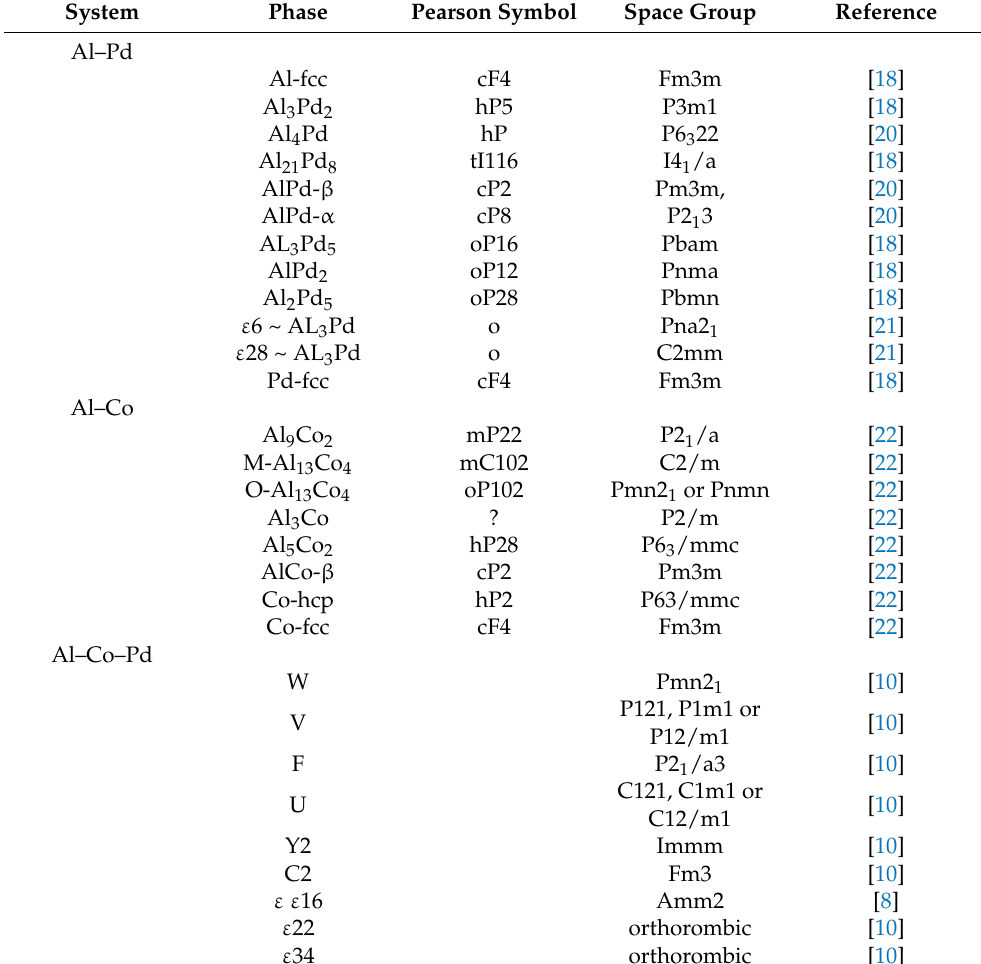
Table 1. Crystallographic data of equilibrium phases relevant to the Al–Co–Pd